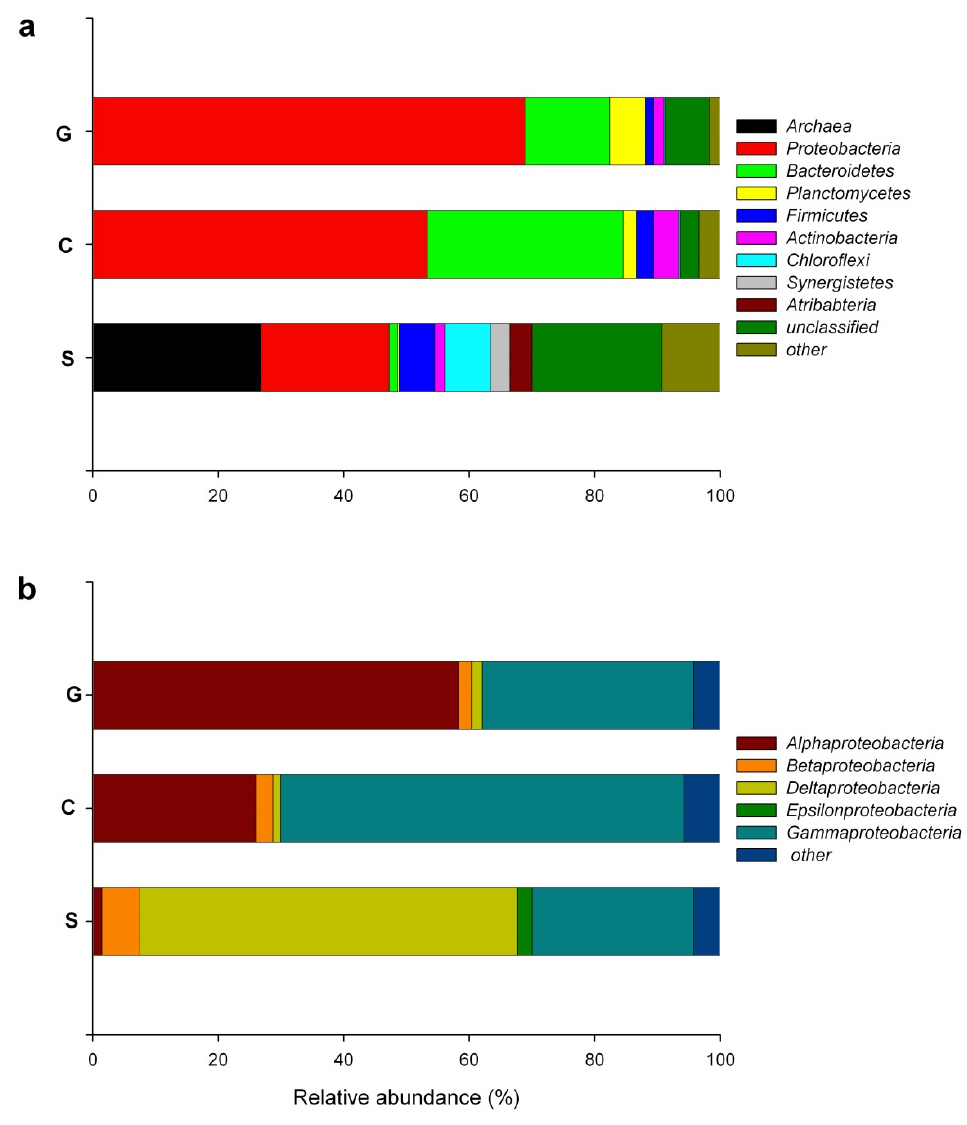
Figure 1. Distribution of 10 phyla and domain Archaea ( a ), and classes of the phylum Proteobacteria ( b ) in the surge pond (S), the clarifier (C) and the guard pond (G) samples (>3% relative abundance of bacteria).